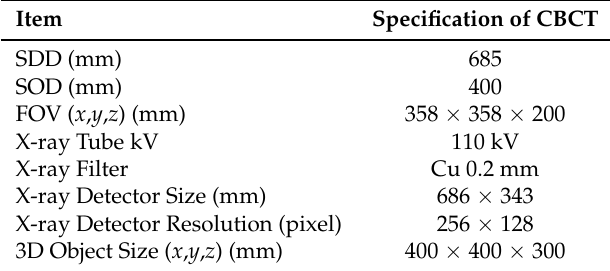
Table 1. Specification of CBCT for